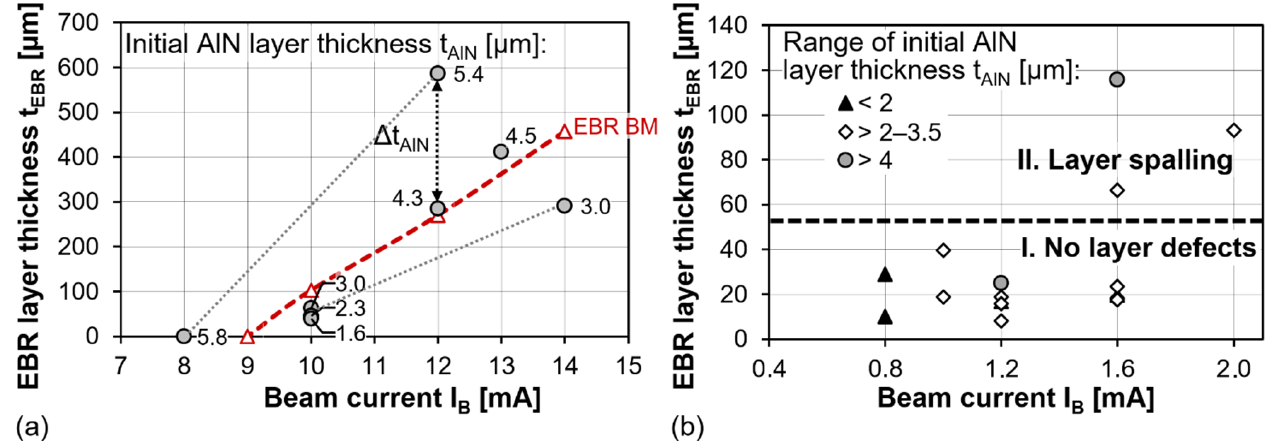
Figure 2. Influence of the initial AlN layer thickness (values given in the diagrams) and the energy input (beam current I B ) on the EBR layer thickness achieved in comparison to the reference EB- remelted Al base material without a nitride layer (EBR) using different beam deflection techniques: ( a ) line scan (v x = 12 mm/s); ( b ) meander (v y = 1.6 mm/s).